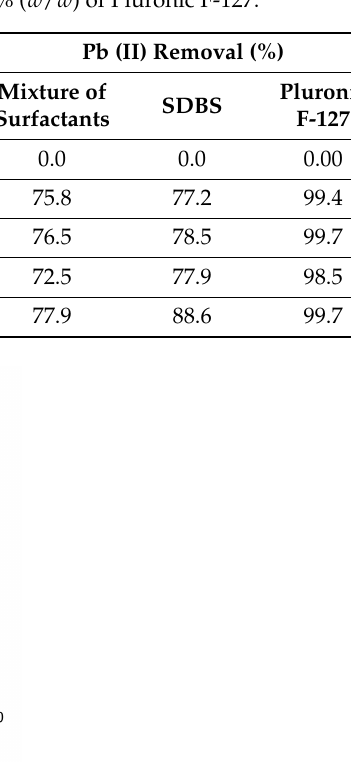
Figure 5. Pb(II) removal applying a suspension of 0.01% MWCNTs dispersed by a mixture of 127. 0.03% ( w / w ) SDBS and 0.03% ( w / w ) of Pluronic F-127. Pb(II) initial concentration was ~3